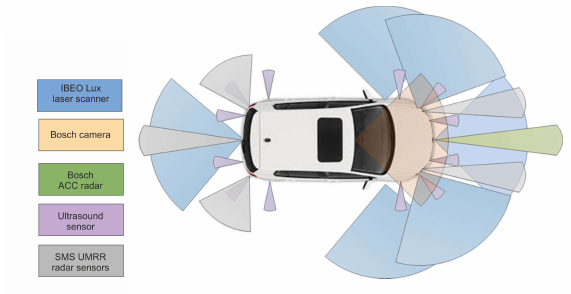
Figure 6. Position and field of view of vehicle based